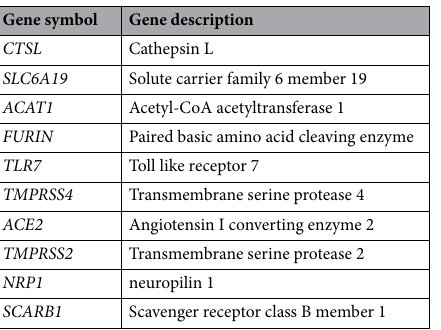
Table 1. Gene set that was found in SARS-CoV-2 entry into host